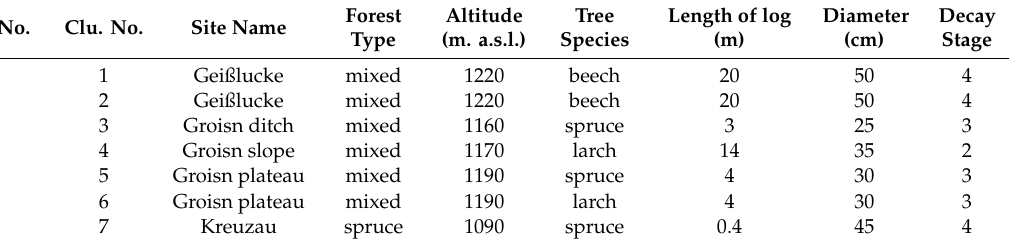
when mature during summer, especially in August—55% remained as setae, 25% disappeared completely. Setae in most cases survived for longer than one year.